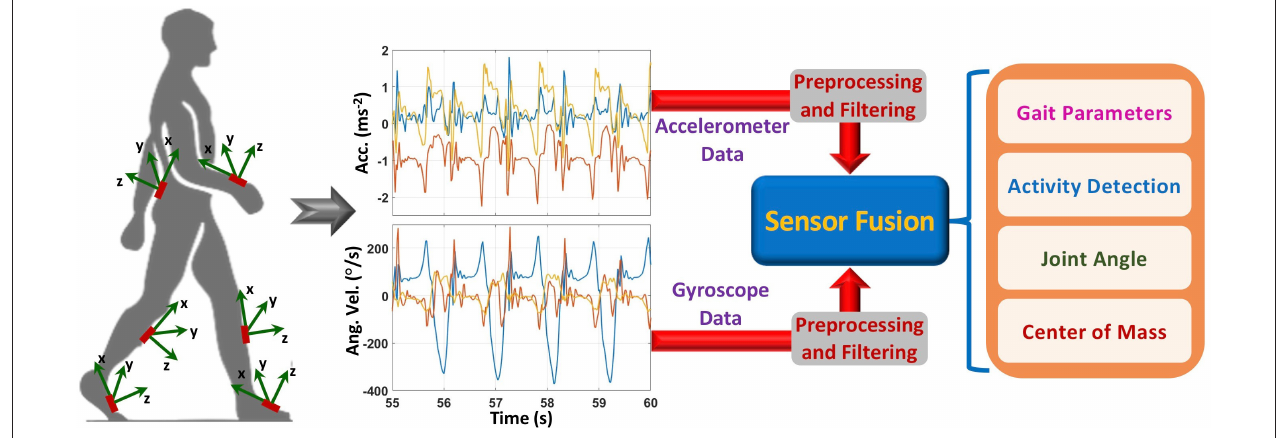
FIGURE 3 | Activity and gait monitoring for fall risk assessment and fall detection using inertial